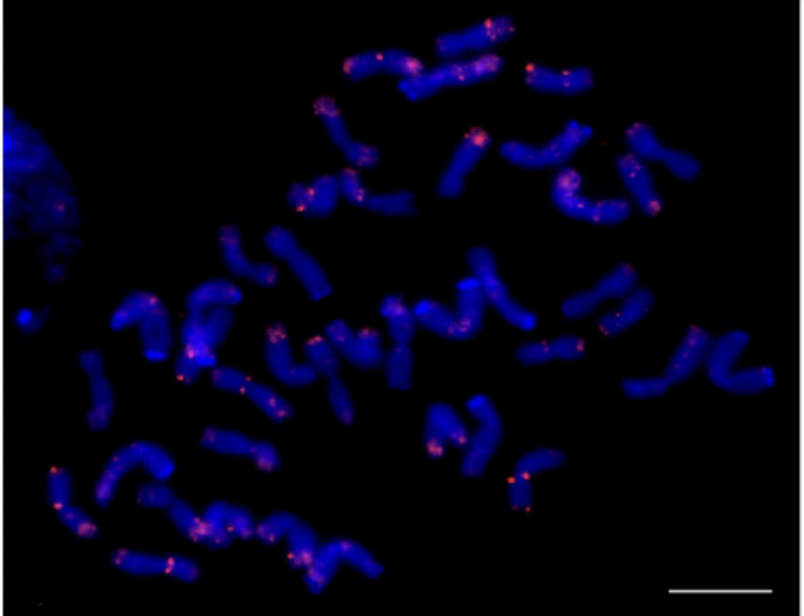
Figure 5. Localization of the P720 tandem repeat on the metaphase chromosomes of triticale cv. Solovey Kharkovskiy using fluorescence in situ hybridization. Red signals indicate the chromosomal localization of the P720 tandem repeat [25]. The bar indicates 10 µ